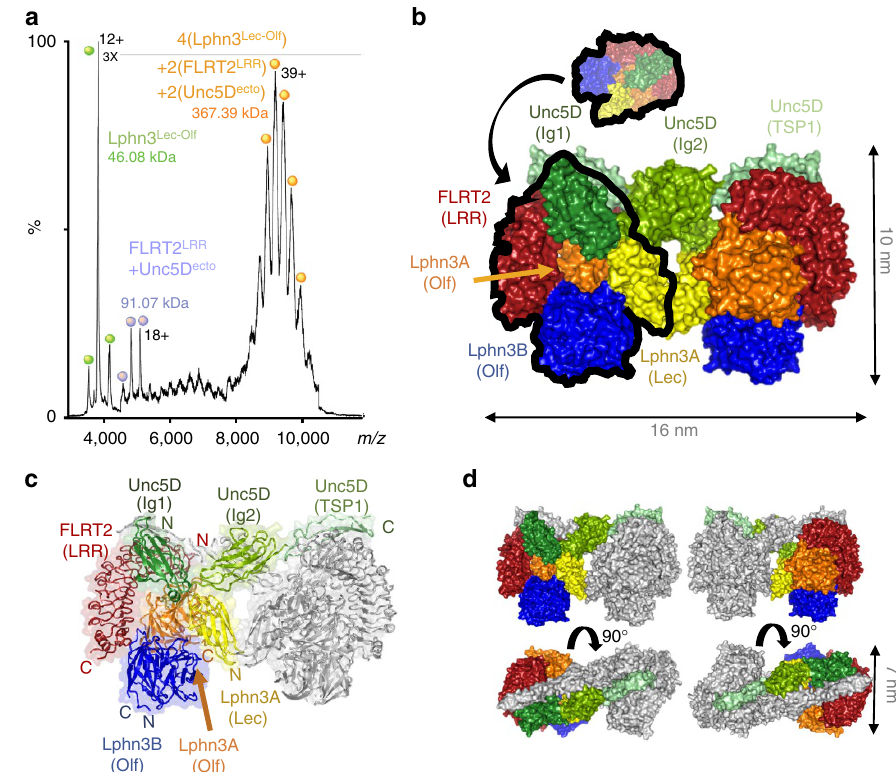
Figure 5 | Crystal structure of the octameric complex of FLRT2 LRR and Unc5D IgIgTSP and Lphn3 Lec–Olf . ( a ) MS reveals that FLRT2 LRR , Unc5D ecto and Lphn3 Lec–Olf form a large oligomer, 2 (cid:3) the size of a putative 1:1:2 complex. ( b ) The crystal structure of FLRT2 LRR , Unc5D IgIgTSP and Lphn3 Lec-Olf reveals a pseudo-symmetric molecule in which two copies of the 1:1:2 tetramer described in Fig. 3 are brought together by antiparallel packing of the Unc5D domains Ig2 and TSP1. The proteins are coloured FLRT2 LRR (red), Unc5D IgIgTSP (Ig1: dark green; Ig2: medium green; TSP1: pale green), Lphn3A Lec–Olf (Olf: orange; Lec; yellow), Lphn3B Lec–Olf (Olf: blue). The Lec domain of Lphn3B is not resolved in the crystal structure, and is presumably flexible within the crystal. ( c ) Cartoon view. One-half of the pseudo-symmetric molecule is shaded in grey. The other colours are as in b . ( d ) Surface views with colours as in c